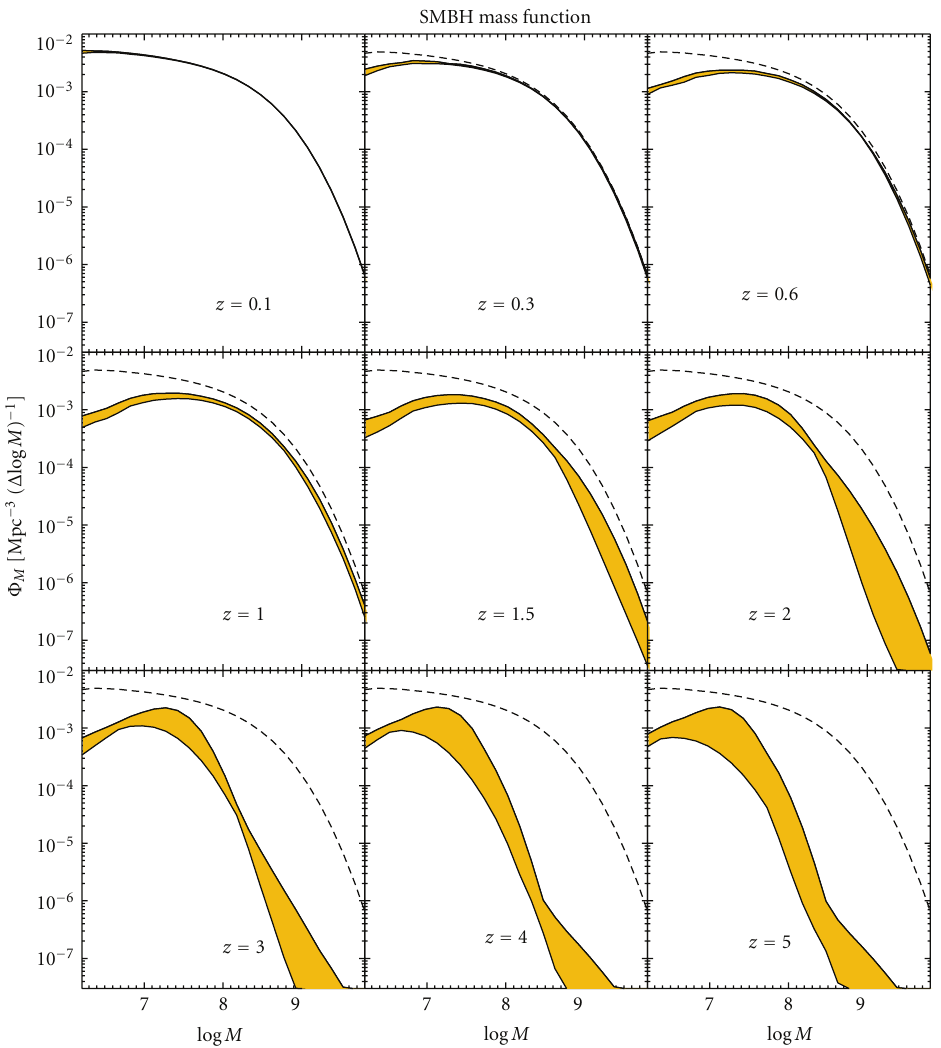
Figure 4: Figure 5 from Merloni and Heinz [63], showing the redshift evolution of their estimated BHMF. The dashed line is the local BHMF and the shaded regions reflect the uncertainty in the BHMF that is due to uncertainties in the AGN luminosity function. The high mass end of their estimated BHMF is built up faster than the low-mass end, a phenomenon that has been called